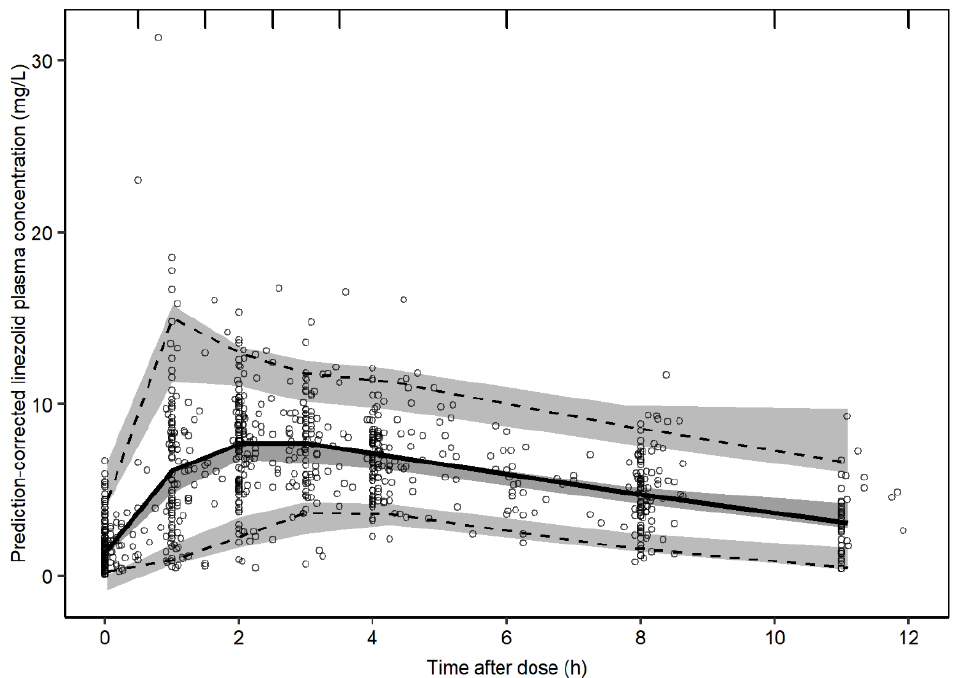
Figure 2. Prediction-corrected visual predictive check (pcVPC) of the final linezolid population pharmacokinetic model. The solid and dashed lines are the median, 2.5th and 97.5th percentiles of the observed data, respectively. The shaded areas (top to bottom) are the 95% confidence intervals of the 97.5th (light gray), median (gray), and 2.5th (light gray) percentiles of the simulated data based on 1000 simulations. Open circles are prediction-corrected observation points.